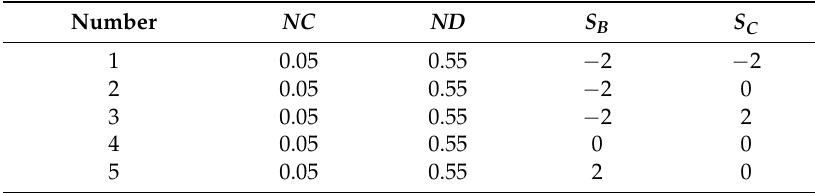
Table 1. Loading parameter values with different blade loading slope ( NC and ND are the first and second interaction point between the straight line and the parabolic line respectively. S B and S C are the slope of the straight line at band and crown respectively).